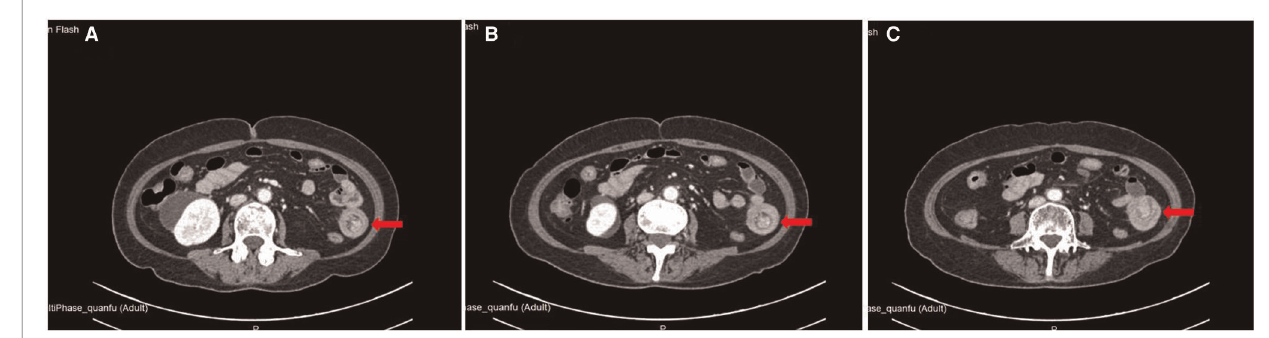
FIGURE 1 | Location of small intestinal intussusception in abdominal enhanced CT.